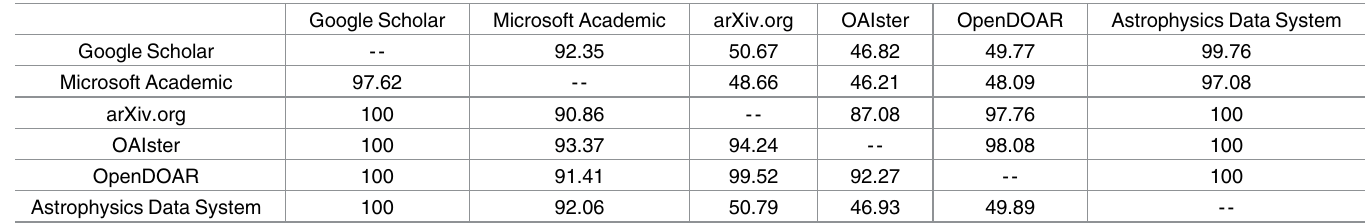
Table 2. Percentage of external overlap of the publication list of the 2001–2013Nobel Laureates in Physics in the open accesssystems(cross-col- umn systemand cross-reference